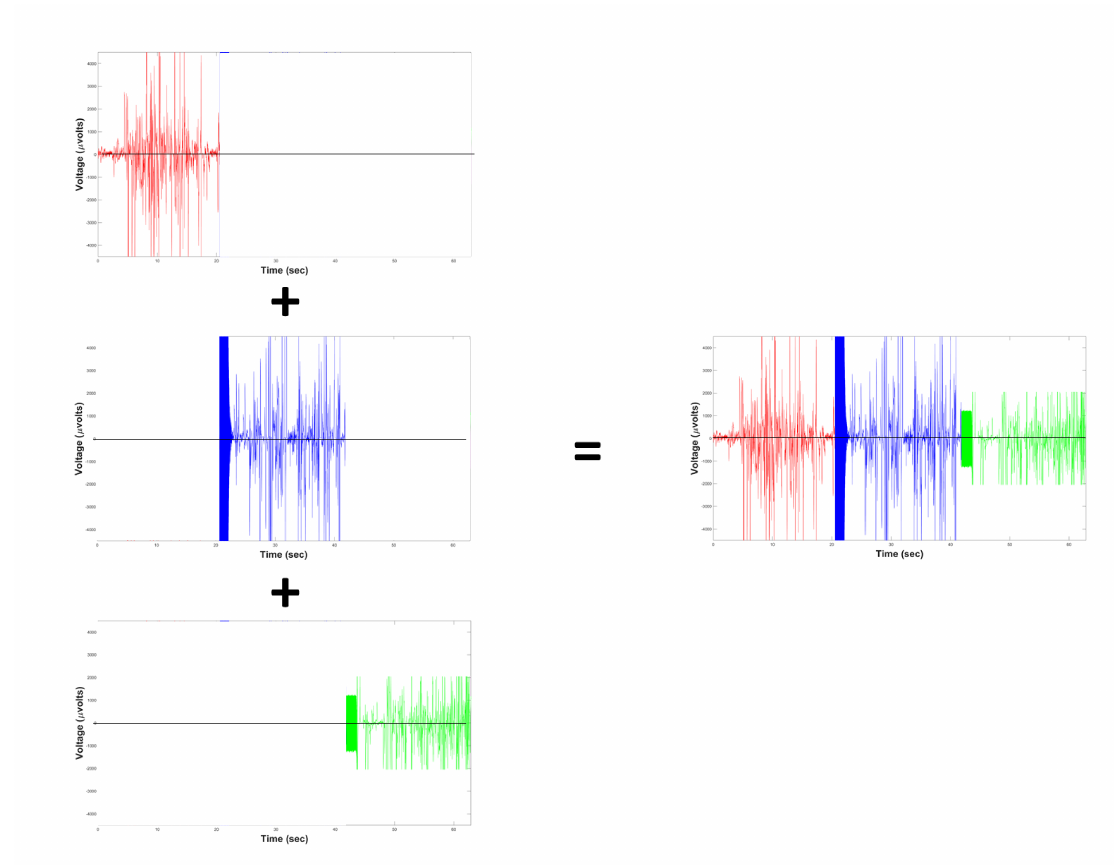
Figure 2. Sequential computing problem when EEG signals are